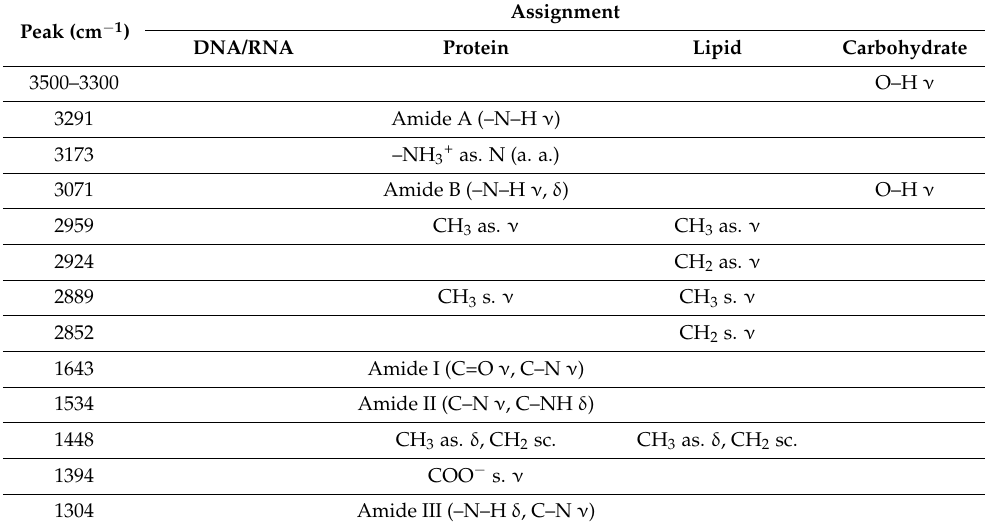
Table 1. FTIR peaks observed in the spectrum of MCF-10A breast cells, with assignments in agree- ment with the data reported in the literature (see Reference [19]and references therein); as = asym- metric, s = symmetric, ν = stretching, δ = bending, sc = scissoring, vbr = vibration, a. a. = free amino acids. The indicated position of every peak is the center of the relative Gauss-cross-Lorentzian func- tion obtained from the deconvolution fit.